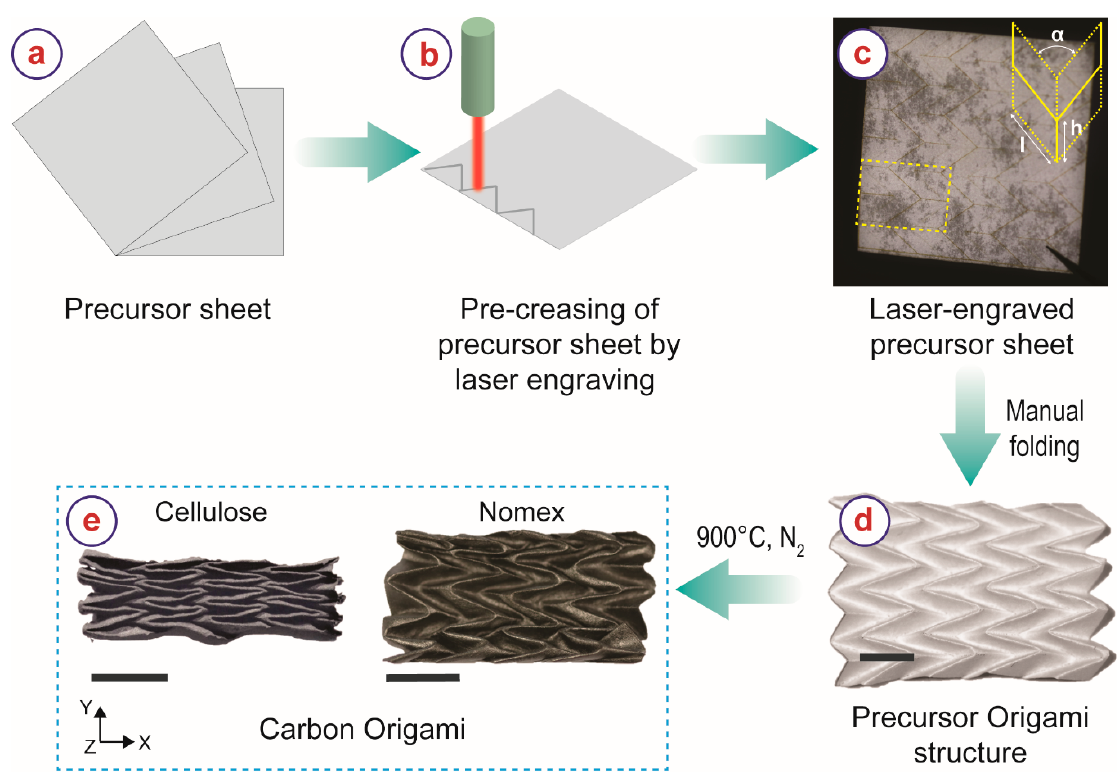
Figure 1. Process-flow illustrating different steps for the fabrication of carbon origami structures from cellulose and Nomex sheets. The scale bars represent 1 cm.